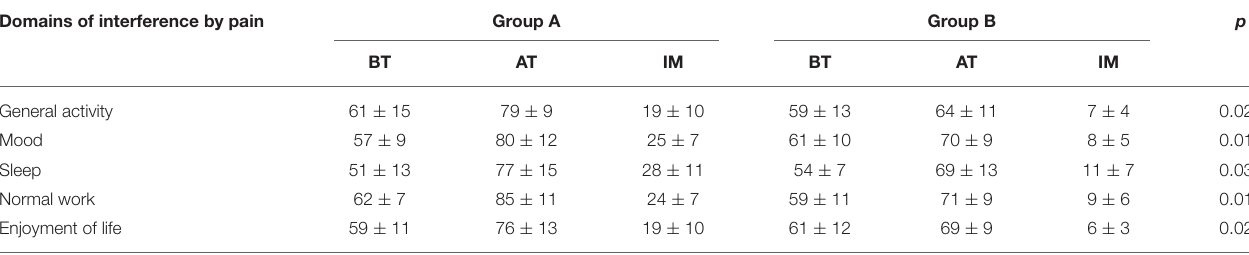
TABLE 4 | Pain interference-related variables from different therapy strategies. Domains of interference by pain